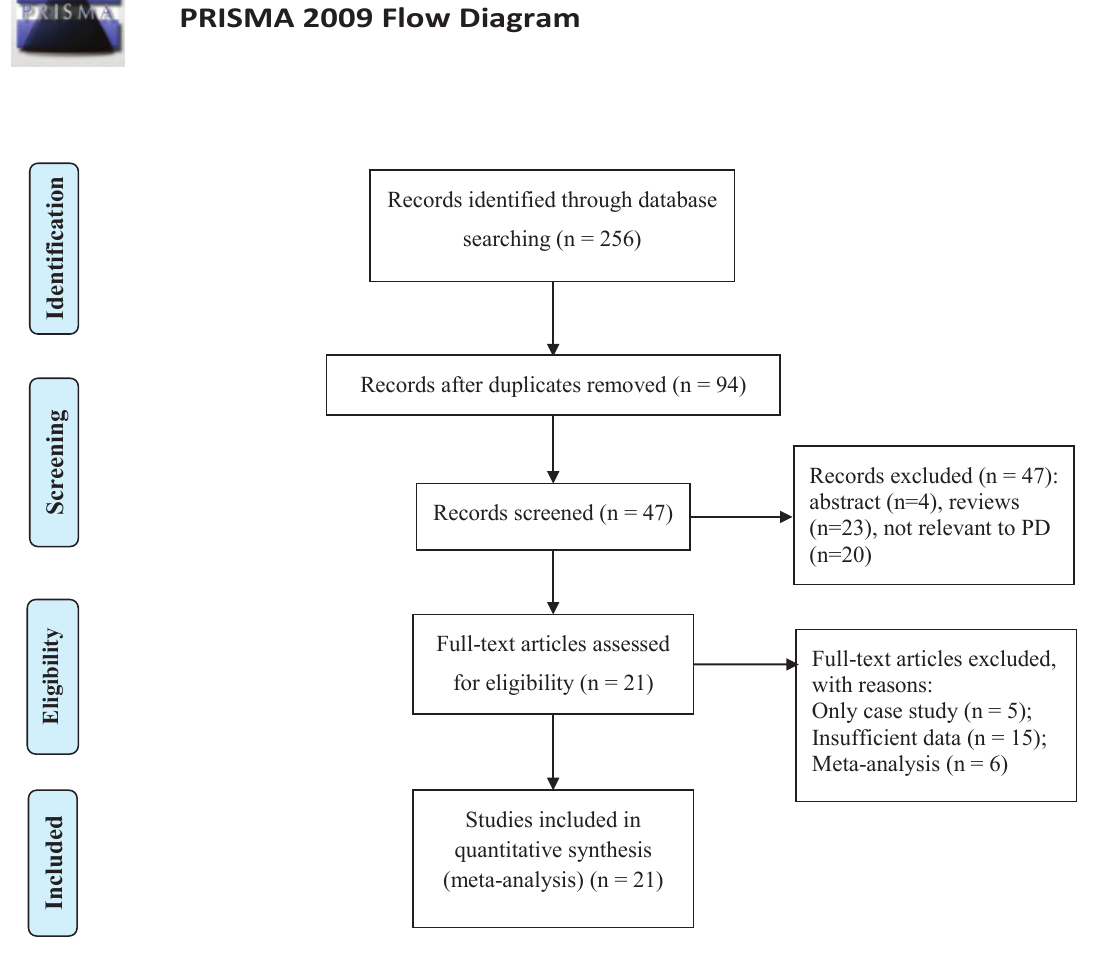
PRISMA 2009 Flow